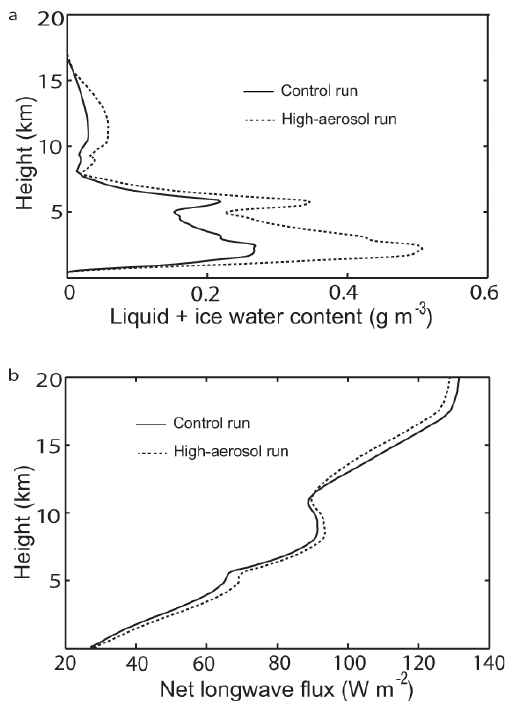
Fig. 12. Vertical distributions of the time- and domain-averaged (a) sum of liquid- and ice-water content and (b) net longwave flux. Water content of precipitable hydrometeors such as rain, snow, graupel, and hail is not included in (a)